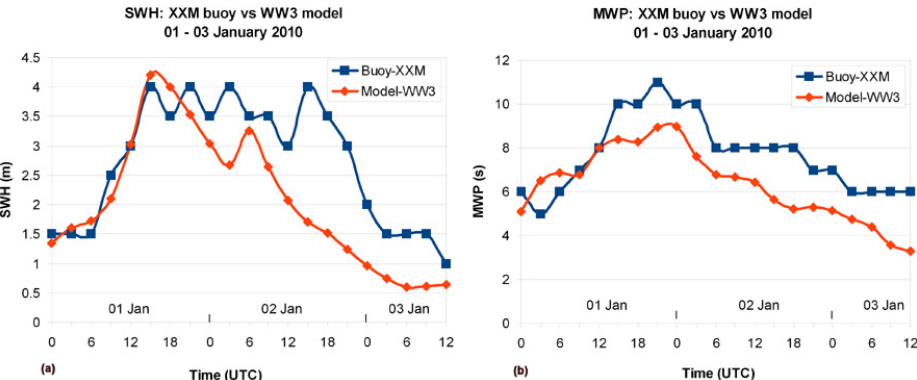
Figure 4. Comparison between XXM buoy (blue line) and ww3 model (orange). Time series for 1–3 January 2010 (hours in UTC). Left panel (a) SWH (m), right panel (b) MWP